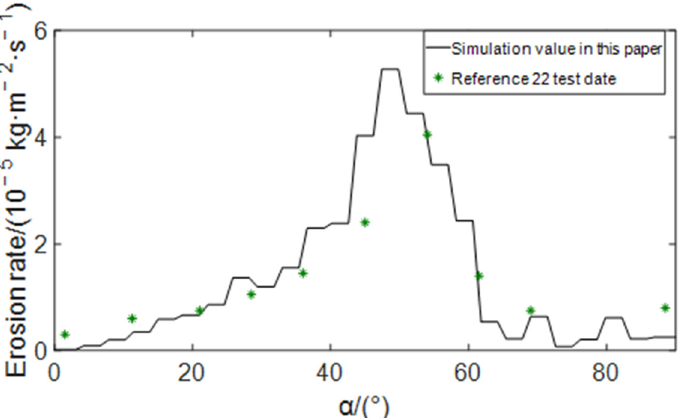
Figure 3. Comparison of erosion rate distribution at the elbow.